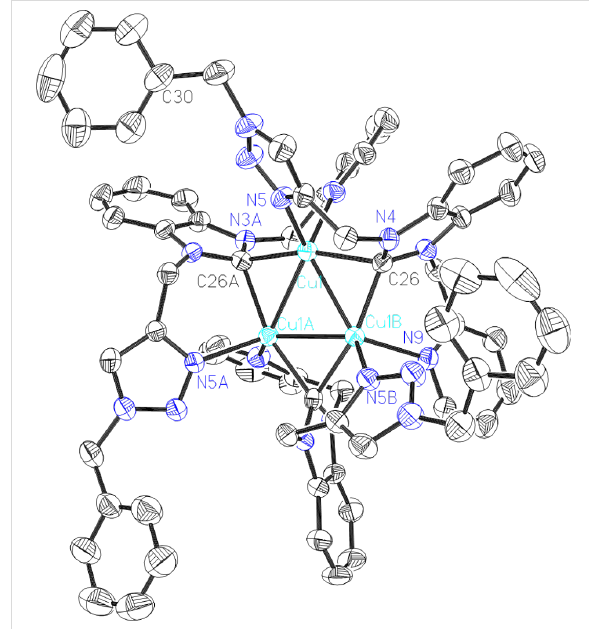
Figure 5: ORTEP drawing of [Cu 3 (L 5 ) 3 ](PF 6 ) 3 ( 6 ). Thermal ellipsoids are drawn at the 30% probability level. Hydrogen atoms and anions have been removed for clarity. Selected bond distances (Å) and angles (°): Cu1-C26 2.092(6), Cu1-N5 2.092(5) , Cu1-C26A 2.024(6), Cu1- N9A 2. 152(5), Cu1-Cu1A 2.5141(11), Cu1-Cu1B 2.5141(11); C26- Cu1-N5 101.8(2), C26-Cu1-C26A 163.7(2), N5-Cu1-C26 92.5(2), C26A-Cu1-N9 92.0(2), Cu1-Cu1A-Cu1B 60.0. Symmetry transformat- ions used to generate equivalent atoms: 1 − x, 1 − y, − z.